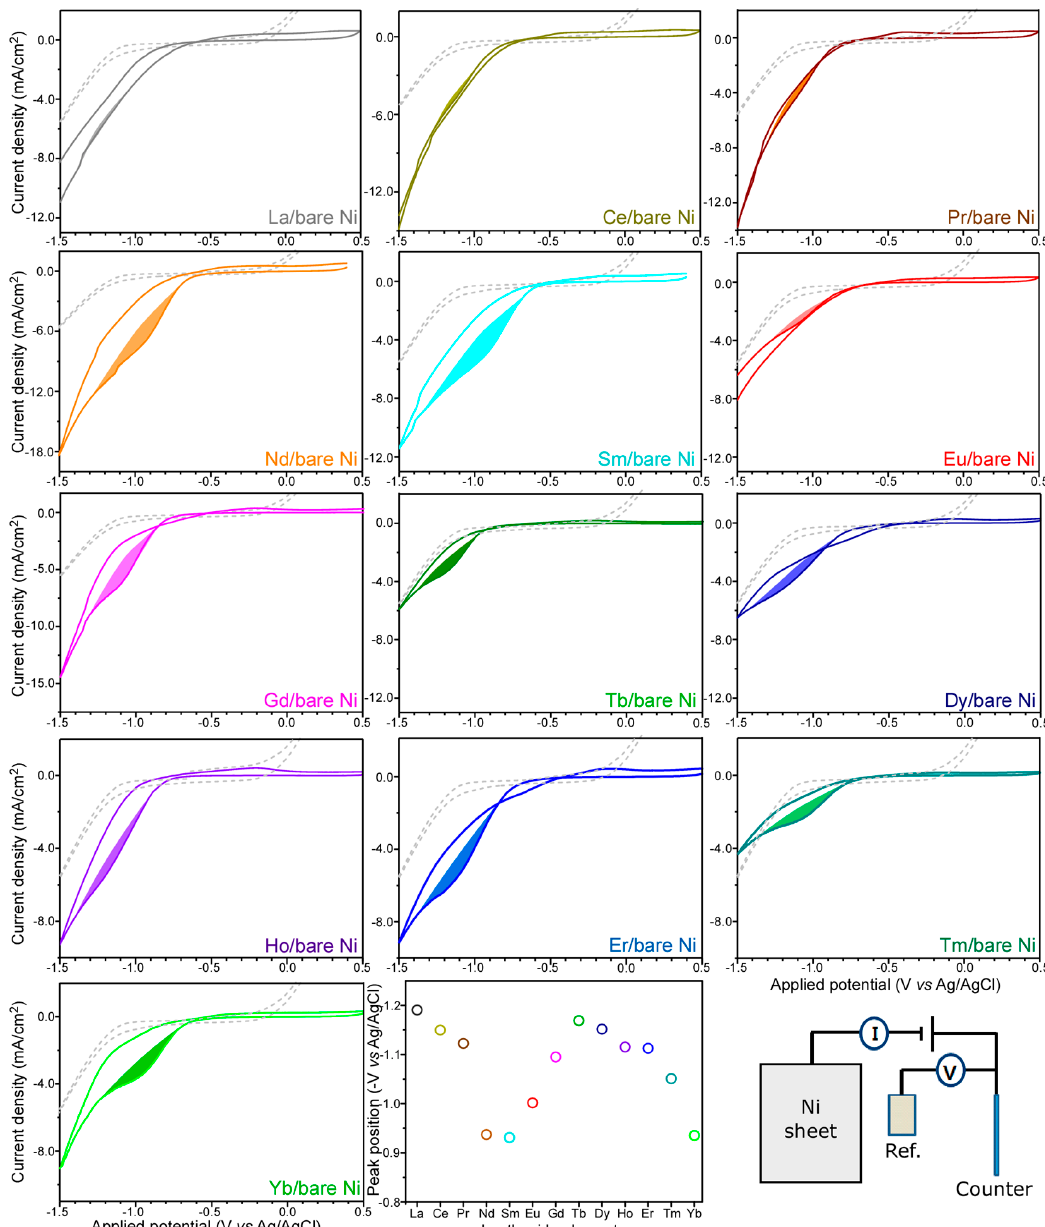
Figure 1. Cyclic voltammetry curves at a scan rate of 0.2 V / s for various 10 mM RE(III) ions in 0.1 M NaClO 4 electrolyte over bare Ni sheets. The reduction peak positions (V vs. Ag / AgCl) are shown with RE elements. A schematic of the three-electrode system used in this study is shown.